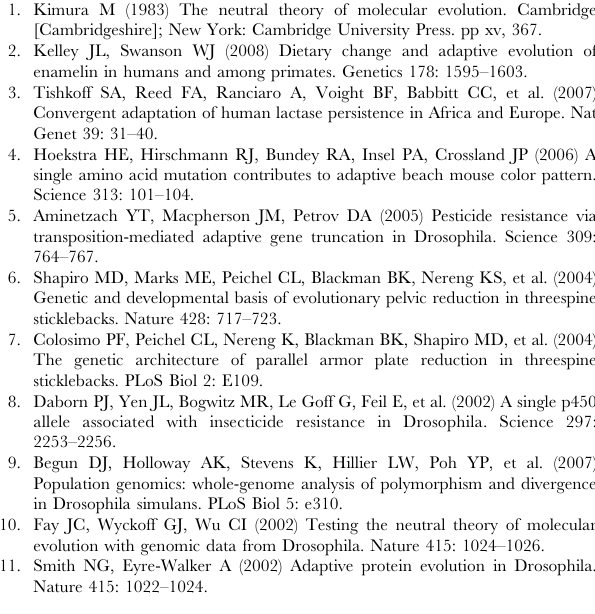
the divergence at conserved noncoding region ( D x ), the number of codons ( FD n ), the number of conserved noncoding sites ( FD x ), and the level of neutral divergence rate ( d neu ). Open circles ( # ) indicate the variables that were not controlled in a particular analysis. (P) indicates the results are based on the Perlegen data, (W) indicates the results are based on the Watson data. P -values are given in parentheses. Table S4 Partial Spearman rank correlation coefficients con- trolling for the depth of sequencing coverage (SC) of Watson data. Partial Spearman rank correlation coefficients between functional divergence [i.e. the divergence at coding sites ( D n ) or the divergence at conserved noncoding region ( D x )] and neutral polymorphism [i.e.,the level of neutral polymorphism ( h neu ) and the level of normalized neutral polymorphism ( P neu = h neu / d neu )], and between functional constraints [i.e.,the number of codons ( FD n ) and the number of conserved noncoding sites ( FD x )] and neutral polymorphism ( h neu and P neu ) are given. Spearman’s partial correlation coefficients were calculated by controlling for all possible combinations of potentially confounding variables. The results of representative combinations are given here. Closed circles ( N ) indicate the controlled variables. These variables are GC content (GC), the density of simple repeats (RD), the depth of sequencing coverage (SC), the divergence at coding sites ( D n ), the divergence at conserved noncoding region ( D x ), the number of codons ( FD n ), the number of conserved noncoding sites ( FD x ), and the level of neutral divergence rate ( d neu ). Open circles ( # ) indicate the variables that were not controlled in a particular analysis. (W) indicates the results are based on the Watson data. P -values are given in